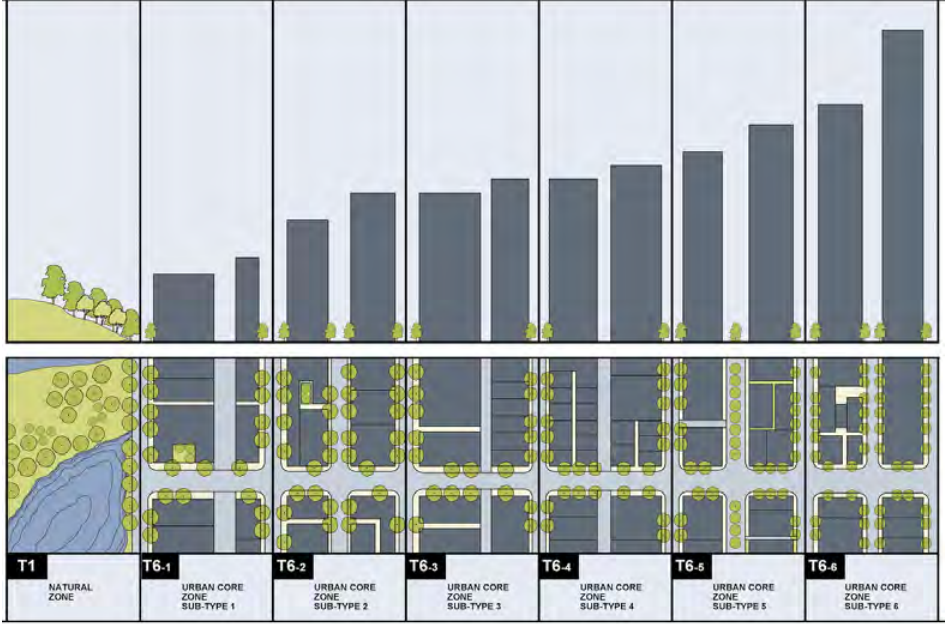
Figure 4. Transect matrix of Tsim Sha Tsui area of Hong